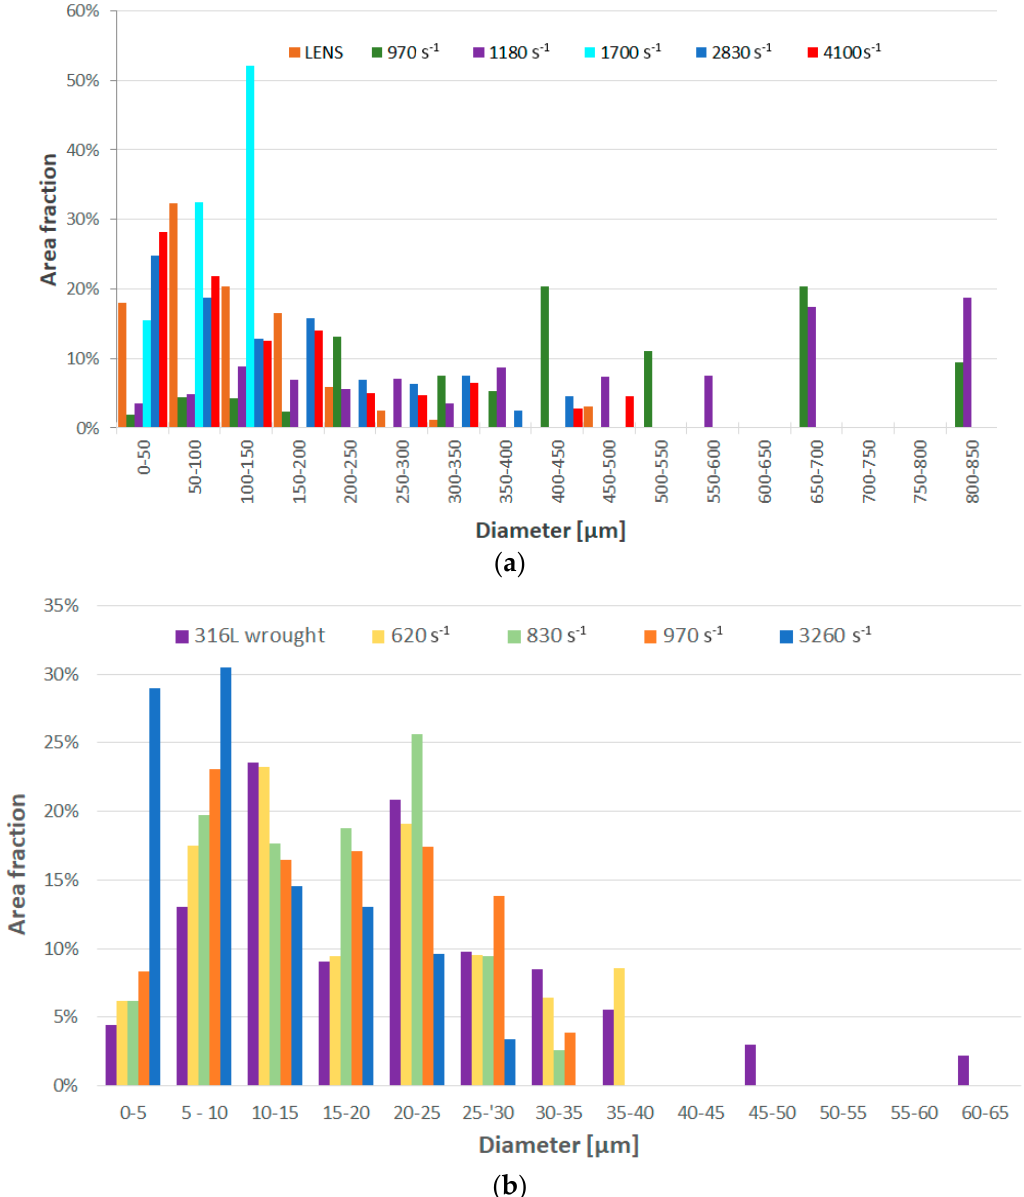
Figure 5. Grain size distribution: ( a ) 316L samples directly after the LENS process; ( b ) SS316L alloy subjected to dynamic deformation.